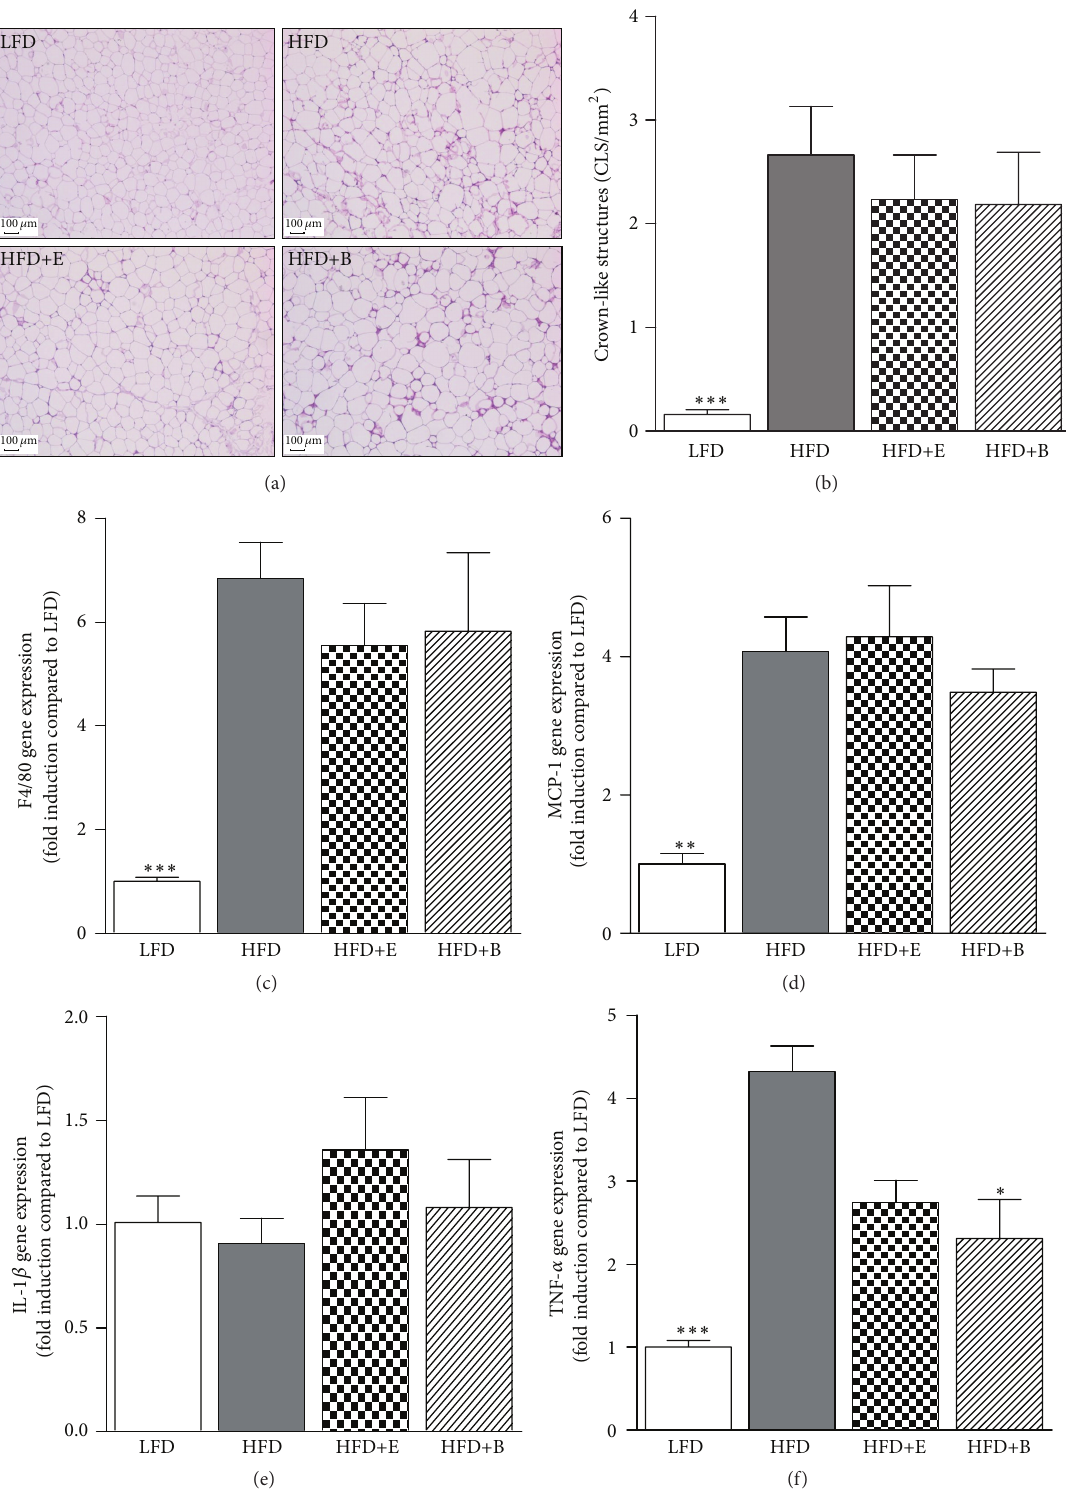
Figure 5: Adipose tissue inflammation at sacrifice. (a) Representative histological pictures of the visceral (gonadal) adipose tissue from different groups demonstrating an increase in the number of crown-like structures upon HFD-feeding which is not attenuated by polyphenols supplementation. (b) Quantification of crown-like structures (c) F4/80 and (d) MCP-1 gene expression confirm this phenotype. Expression of the IL-1 𝛽 gene is not affected (e) in contrast to Tnf (f) which is significantly lower in the HFD+B group compared to HFD. Significant from HFD ( ∗ 𝑝 < 0.05 , ∗∗ 𝑝 < 0.01 , and ∗∗∗ 𝑝 < 0.001